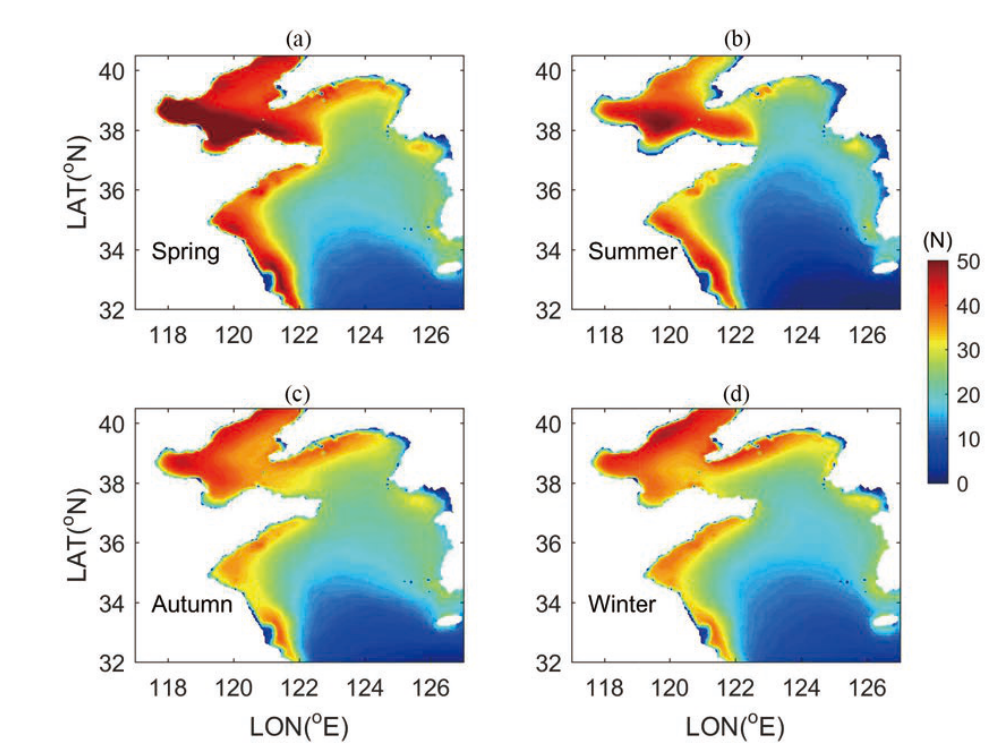
Figure 10. Seasonal average wave energy event number (( a ) Spring; ( b ) Summer; ( c ) Autumn; ( d )